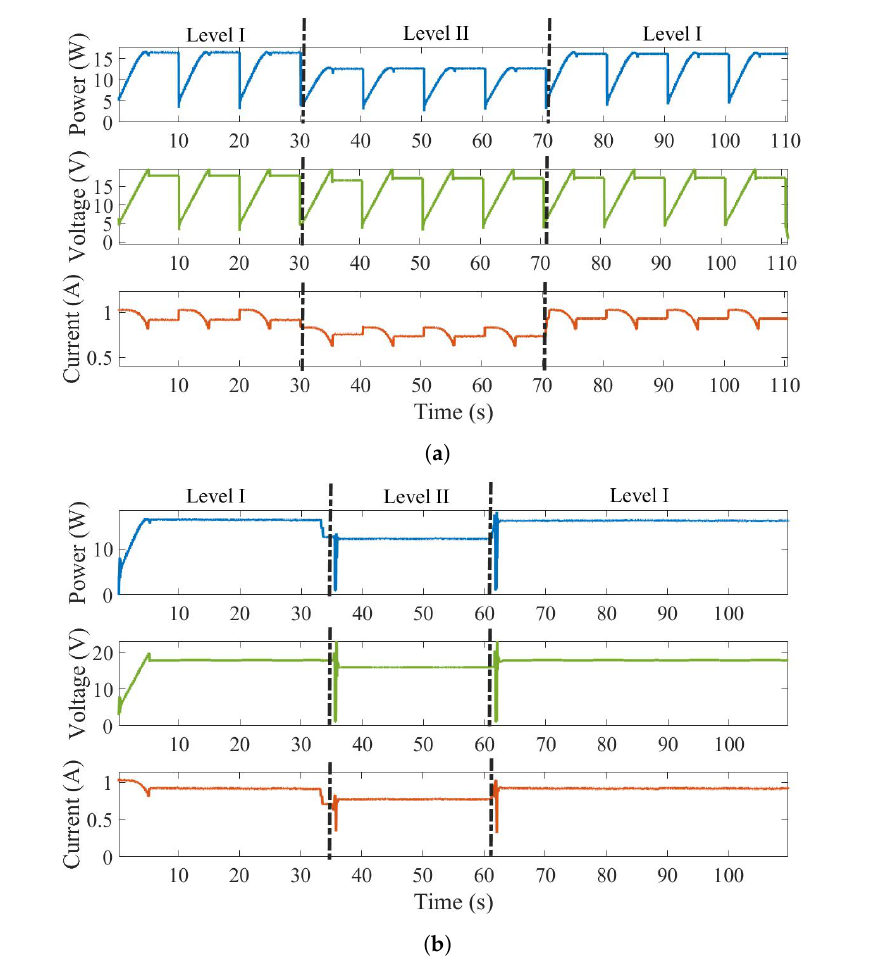
Figure 14. Experimental results. ( a ) Conventional scanning; ( b ) proposed GMPPT